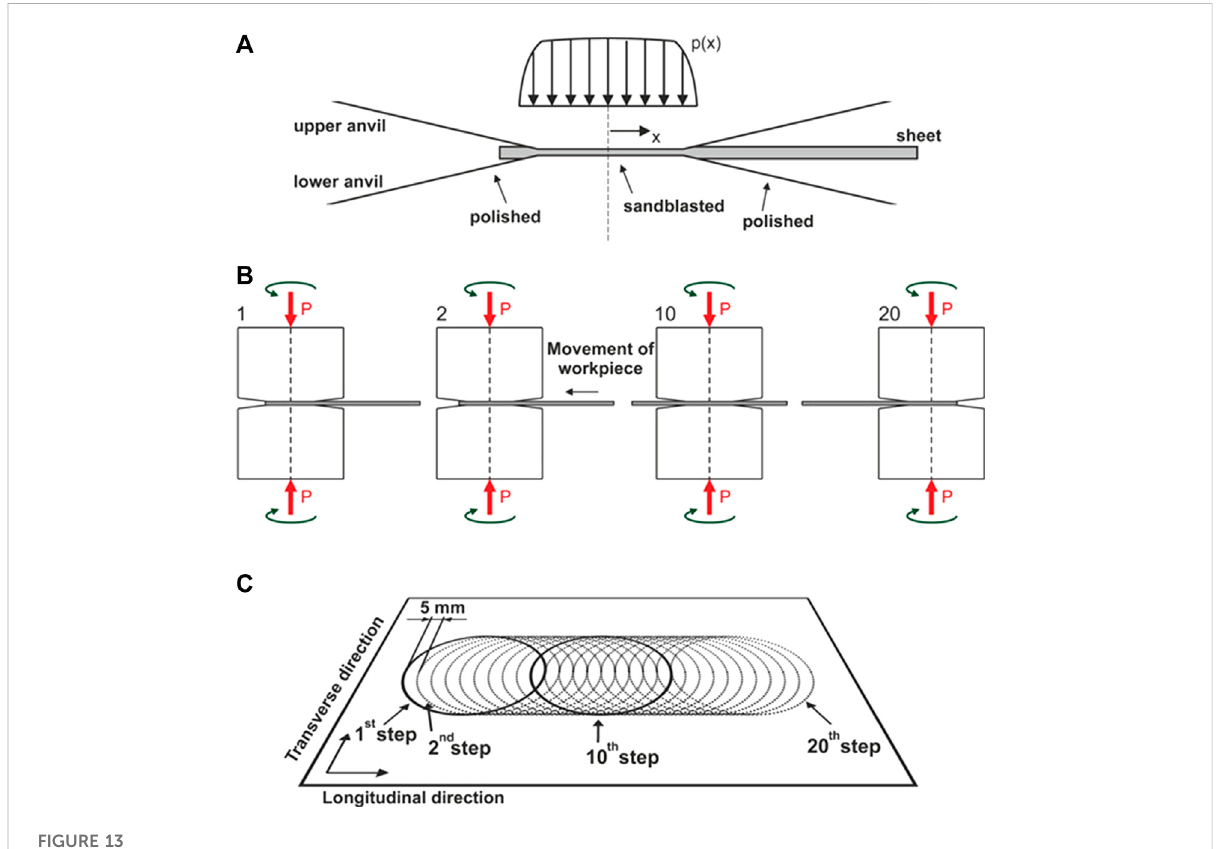
FIGURE 13 Principle of P-HPT process. (A) Schematic of the anvil and pressure distribution on the sheet; (B) representation of several P-HPT steps; (C) deformation zone on the sheet with increasing deformation steps (Hohenwarter and Pippan, 2018).